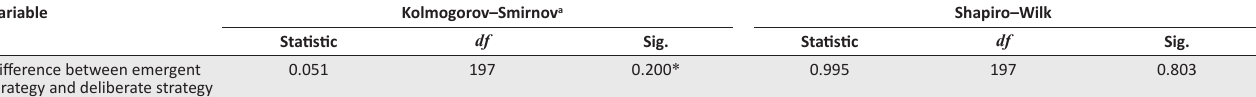
TABLE 5: Statistical analysis of the difference between emergent strategy and deliberate strategy using Kolmogorov–Smirnov test for normality. Variable Kolmogorov–Smirnov a Shapiro–Wilk Statistic df Sig. Statistic df Sig. Difference between emergent 0.051 strategy and deliberate strategy